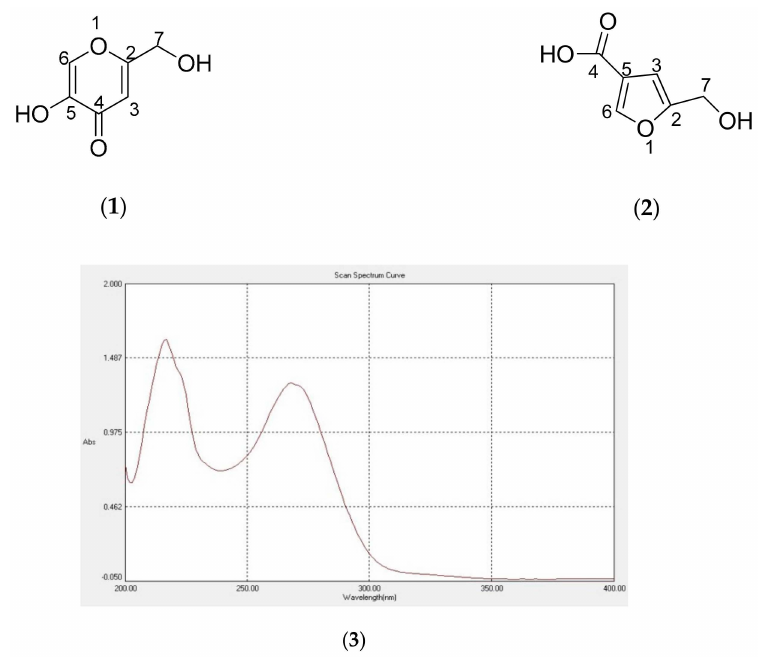
Figure 2. Chemical structures of ( 1 ) kojic acid and ( 2 ) flufuran, and the ( 3 ) UV Spectra of 1